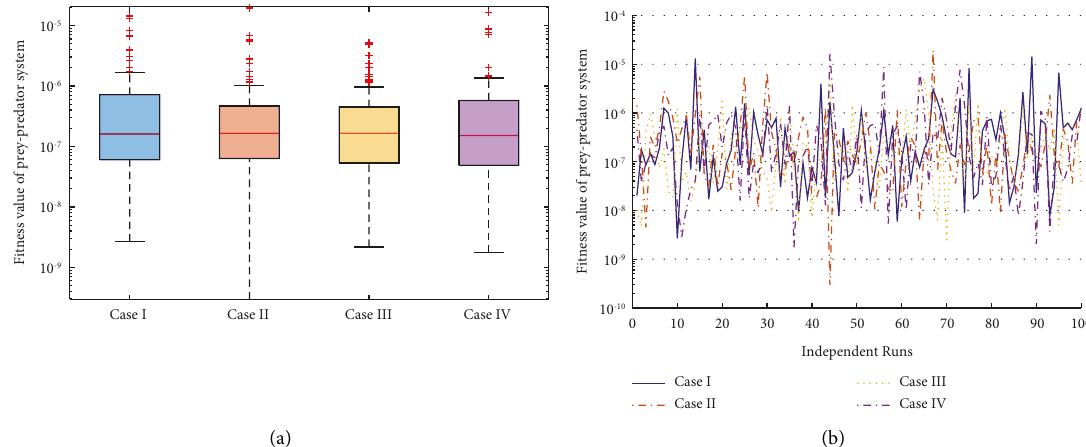
Figure 11: Comparison between the box plots and convergence graphs of fitness evaluation over 100 independent runs for the prey- predator model with variations in the increasing rate of immigrant prey. (a) Box plots for fitness evaluation of the prey-predator model with variations in α . (b) Convergence of the fitness value of the prey-predator model with variations in α 2